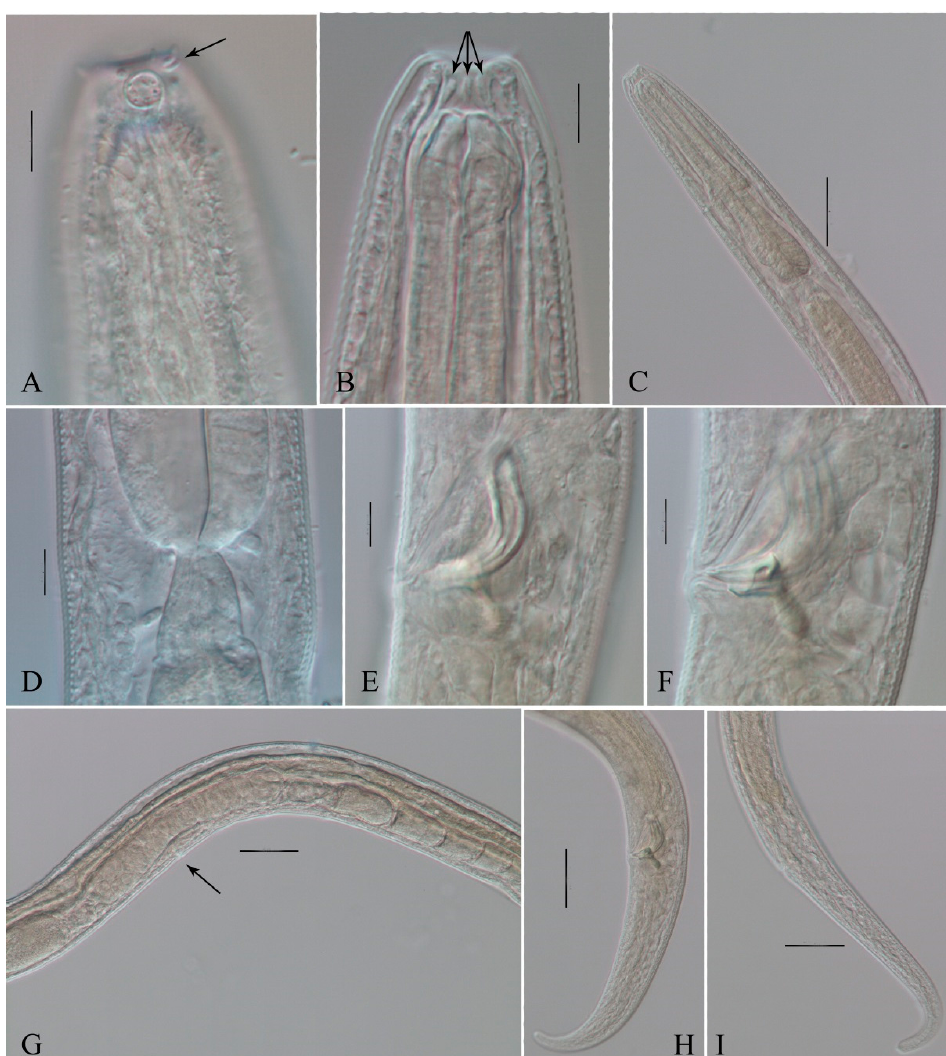
Figure 4. Anticyathus communis sp. nov.—DIC photomicrographs. ( A ) lateral view of male head end, showing amphid and cephalic setae; ( B ) lateral view of female head end, showing buccal cavity and longitudinal reinforcements; ( C ) lateral view of female anterior part, showing pharynx; ( D ) lateral view of male body part, showing cardia; ( E ) lateral view of male body part, showing spicule; ( F ) lateral view of male body part, showing gubernaculum and apophysis; ( G ) lateral view of female body part, showing ovary and vulva; ( H ): lateral view of male tail region; ( I ) lateral view of female tail region. Scale bar: ( A , B , D – F ) = 10 µm; ( C , G – I ) = 50 µm.